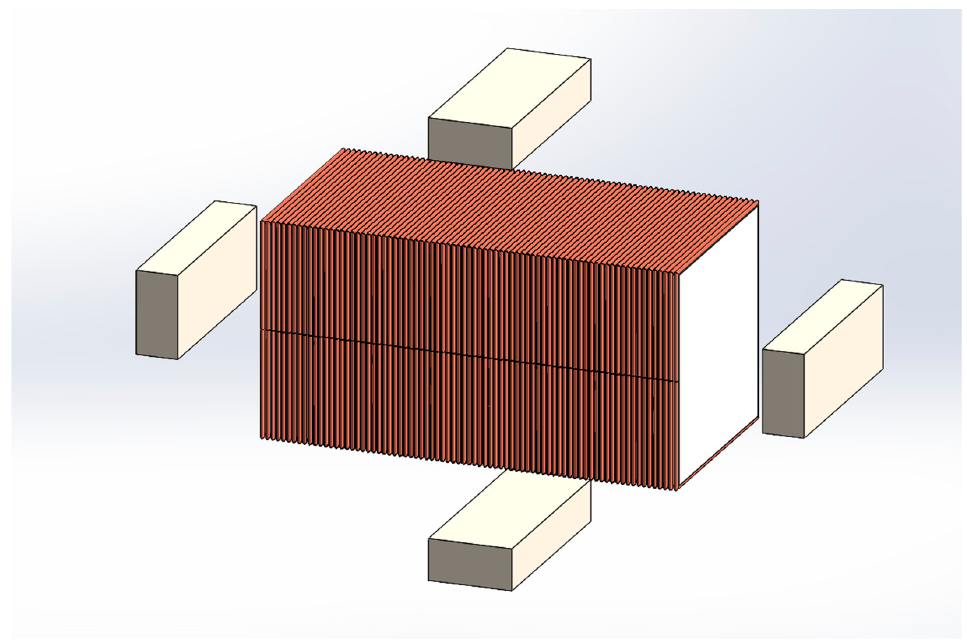
Figure 6. Arrangement of tank with vertically wound coil.